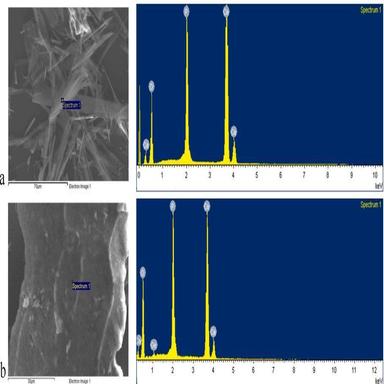
Energy dispersive spectra with the elemental characterization of HAp (a) and Ge-HAp (b), denoting the three elements detected in HAp, namely Ca, O and P, and the four elements detected in Ge-HAp, namely Ca, O, Ge, and P.